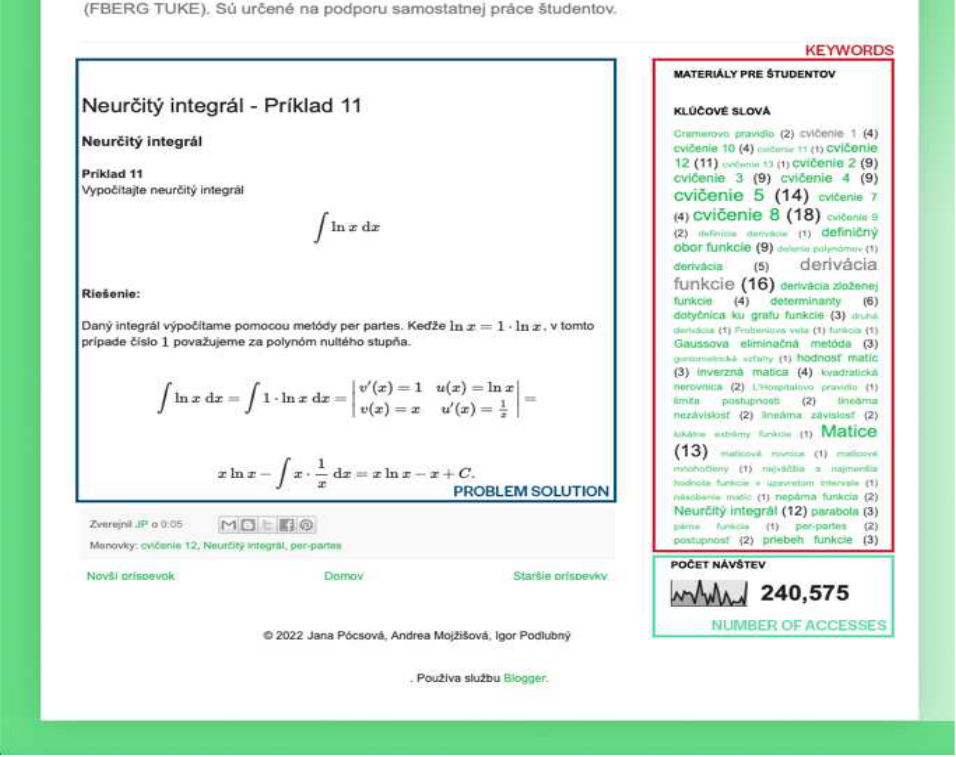
Figure 6. An example of a solution of a sample problem in Blogger [18]. Color frames denoting separate areas are added for clarity.